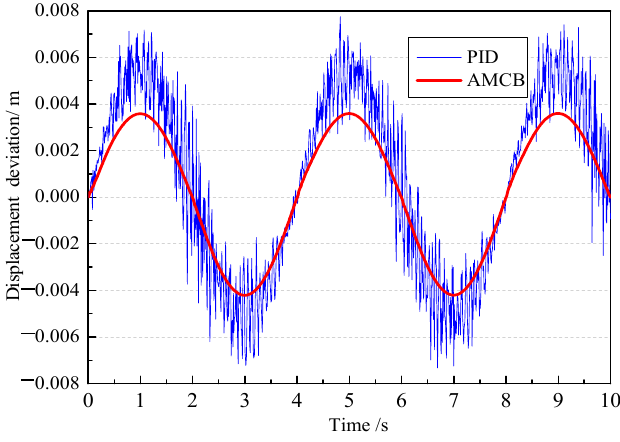
Figure 8. Displacement error response curves.